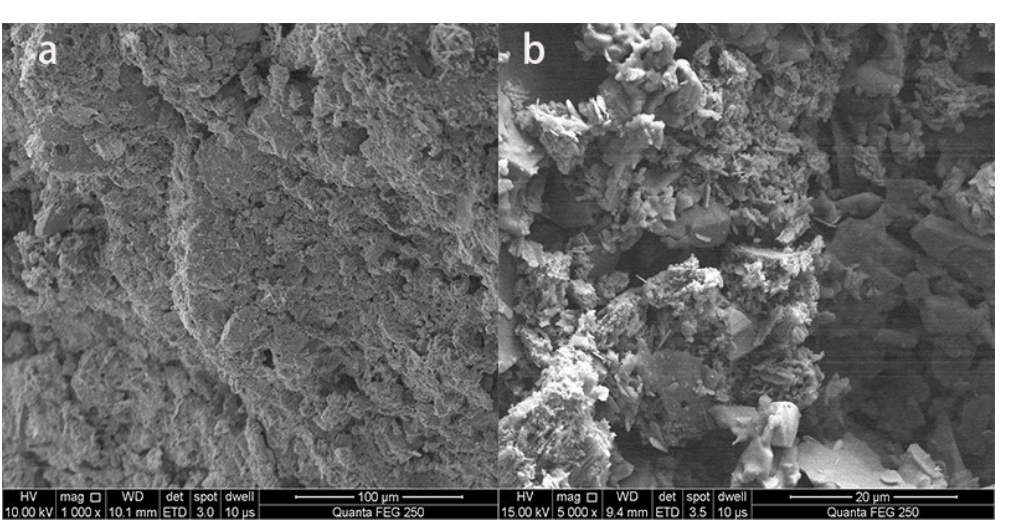
Figure 2. Micromorphology of SPM 1000× ( a ) and 5000× ( b ).